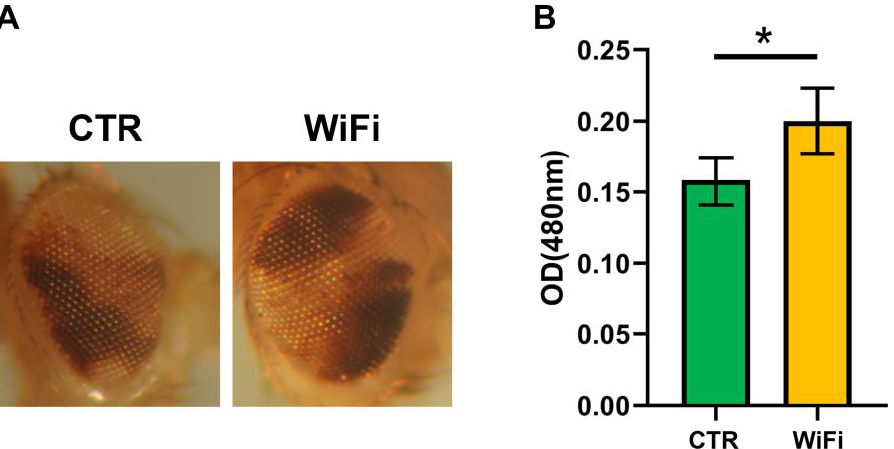
Figure 3. ( A ) Images of the BL2 PEV pattern in the adult fly eye taken from randomly selected individuals in each experimental group. ( B ) Quantitative assessment of pigment levels in the adult fly eyes from 2–3-days-old control and WiFi-exposed BL2 males. Statistical significance was determined using the Paired t test (* p ≤ 0.05).